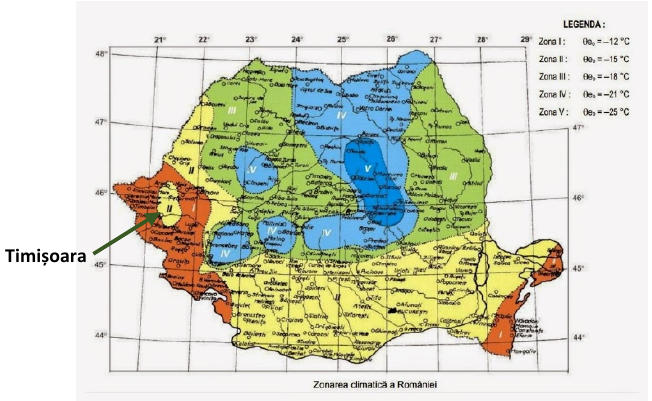
Figure 3. Location of the case study considering the Romanian map for the winter climatic zones. Reprinted from [20].